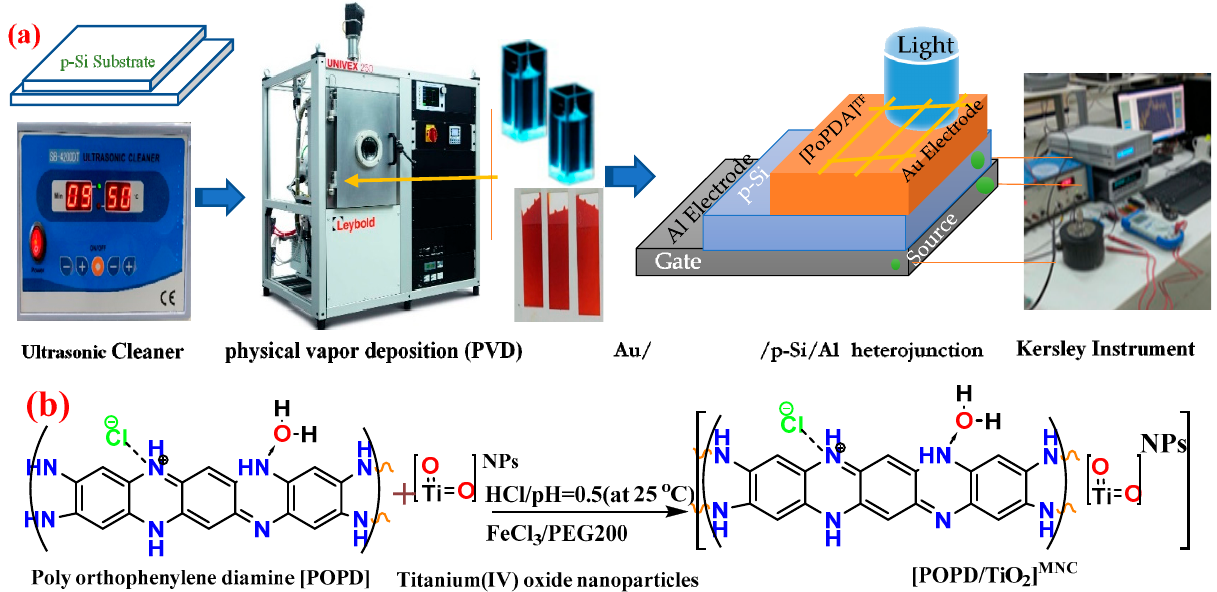
Figure 1. ( a ) The fabrication process of Au/[PoPDA/TiO 2 ] MNC /p-Si/Al heterojunction diodes and ( b ) reaction scheme.